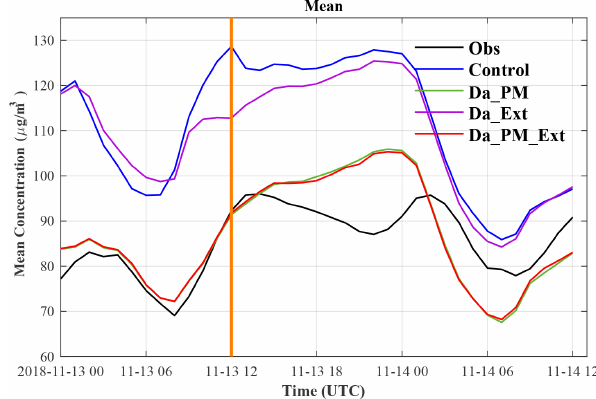
Figure 8. Variation of the regional mean PM 2 . 5 MC over time mea- sured and simulated by the four experiments (the vertical orange line separates the DA and forecast periods; the black line signifies measurements; the blue line signifies that obtained from the control experiment; the green, purple, and red lines signify that obtained from the DA_PM, DA_Ext, and DA_PM_Ext experiments, respec-